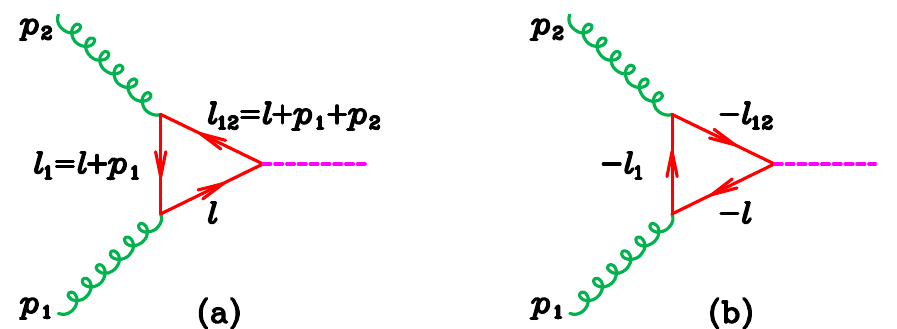
Figure 1 . Triangle diagrams showing the production of a Higgs boson by gluon